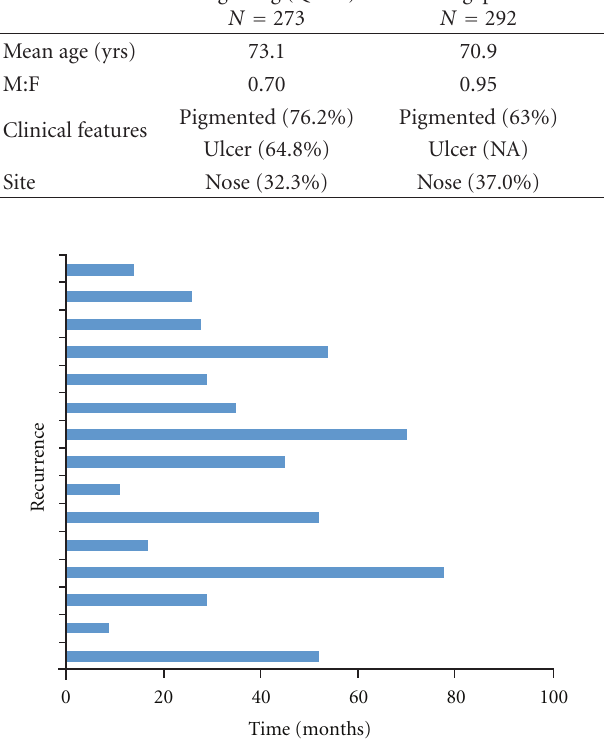
Figure 7: A graph depicting tumour recurrence over